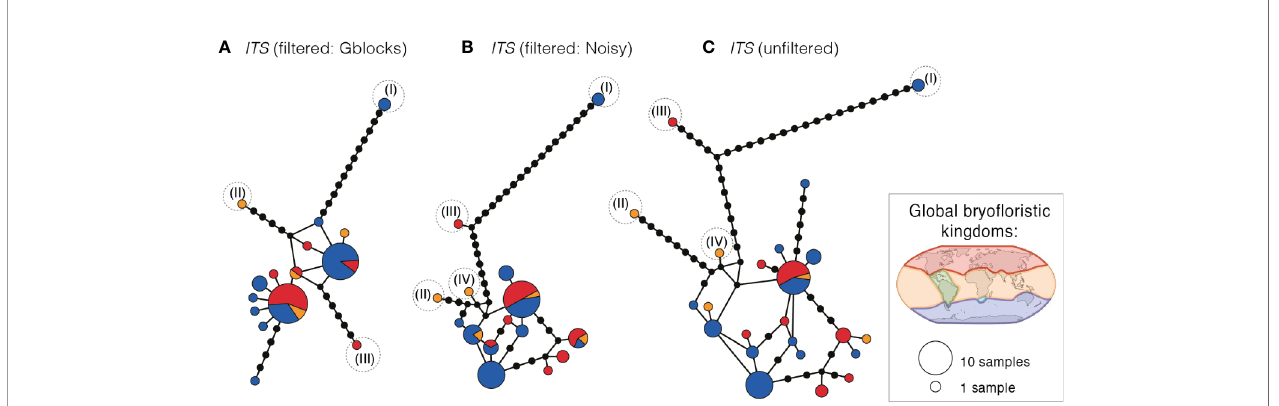
FIGURE 3 | Haplotype networks of ITS for Ceratodon purpureus , after treatment with (A) GBLOCKS, (B) NOISY or as (C) original data. Haplotype circle sizes and colors correspond to the number of specimens and globally recognized bryo fl oristic kingdoms (see legend; Scho fi eld, 1992), respectively. Branches represent mutations between haplotypes, with mutations shown as 1-step edges. Numbers (I – IV) indicate the placement of the same samples falling in clades I – IV as resolved in the cpDNA data sets (see Figure 2